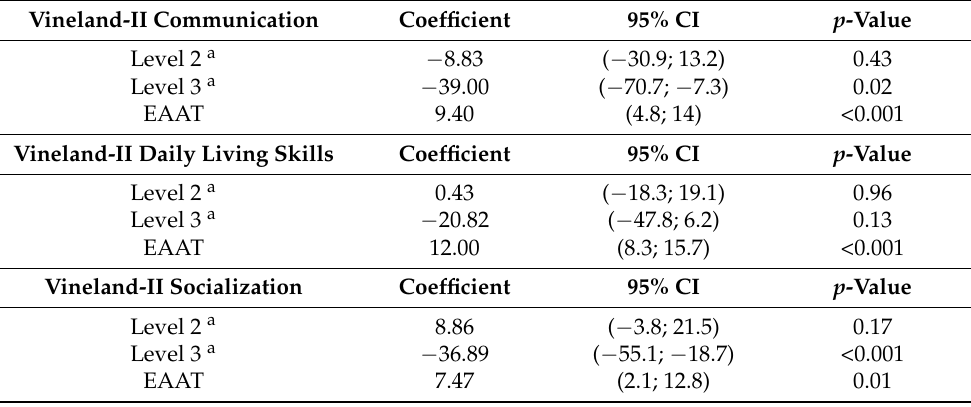
Table 2. Association between the EAAT and the